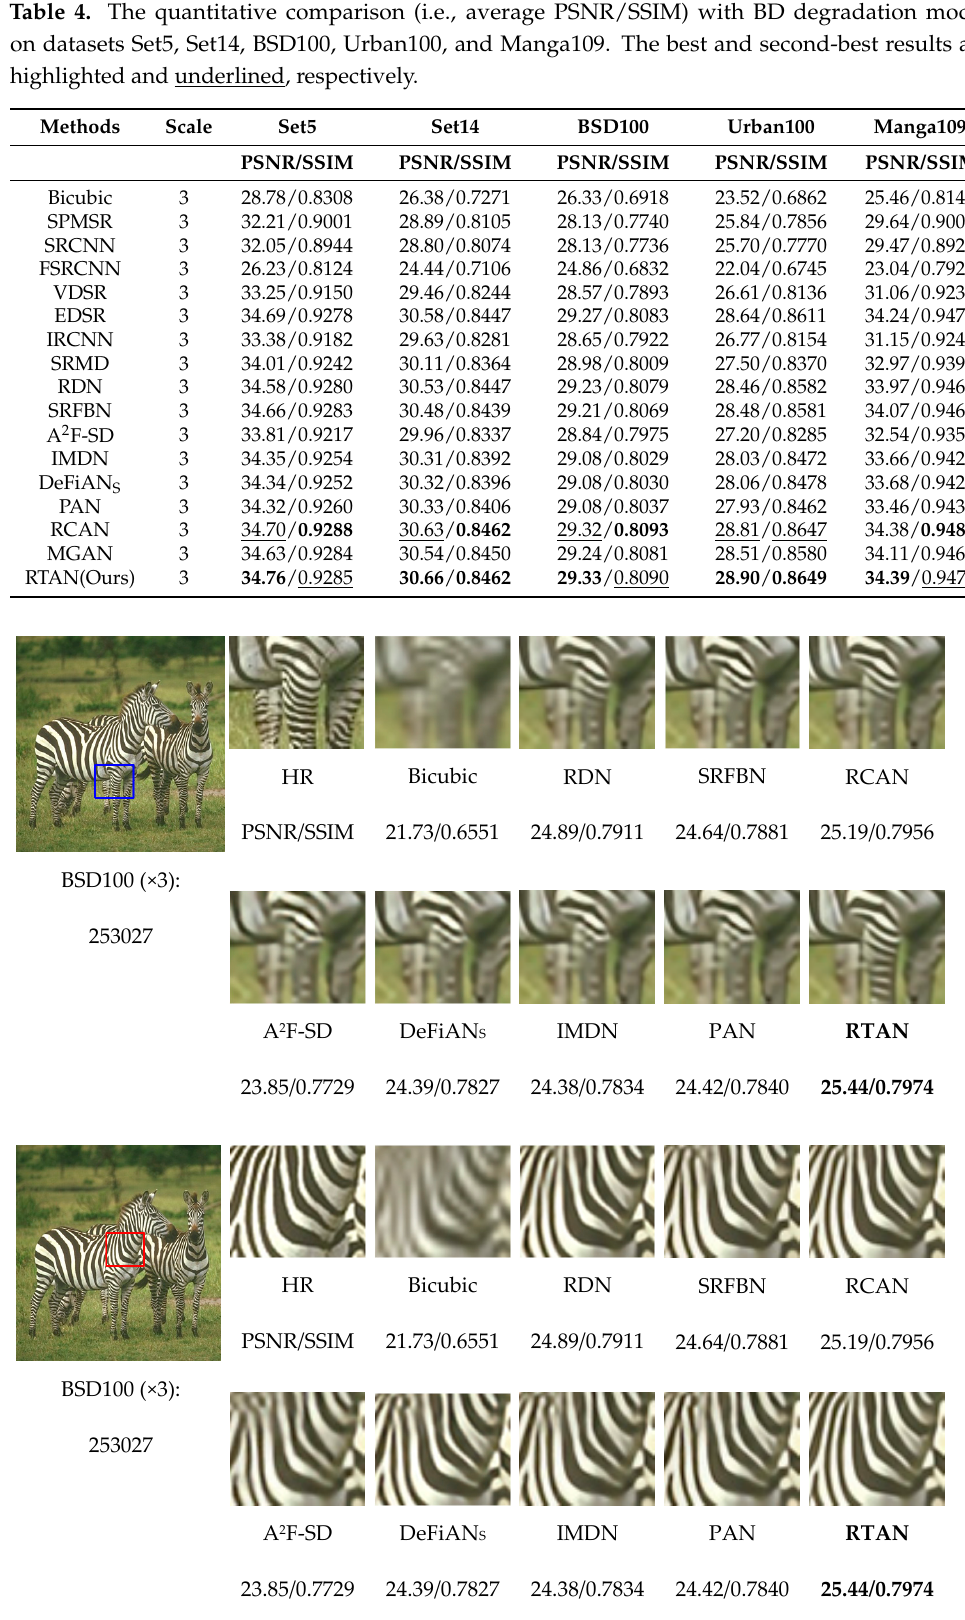
Figure 5. The visual comparisons of × 3 SR with BD degradation model on BSD100 dataset. The best results are highlighted.